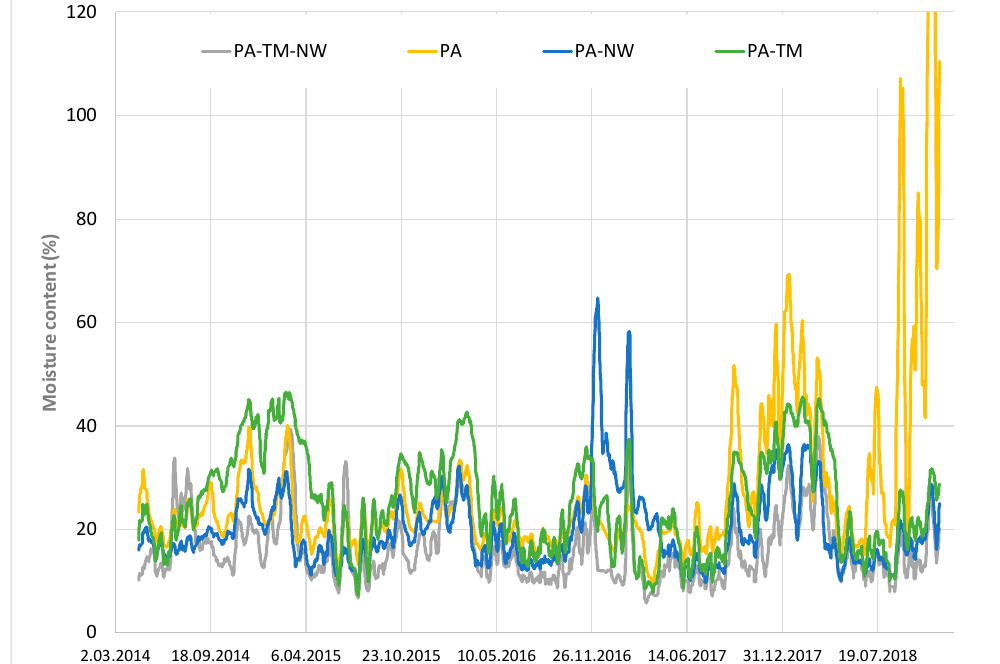
Figure 2. Distribution of moisture content in various wood-based materials exposed as decking of the model house in Ljubljana in the period between 11 April 2014 and 26 November 2018 ( n = 3381).